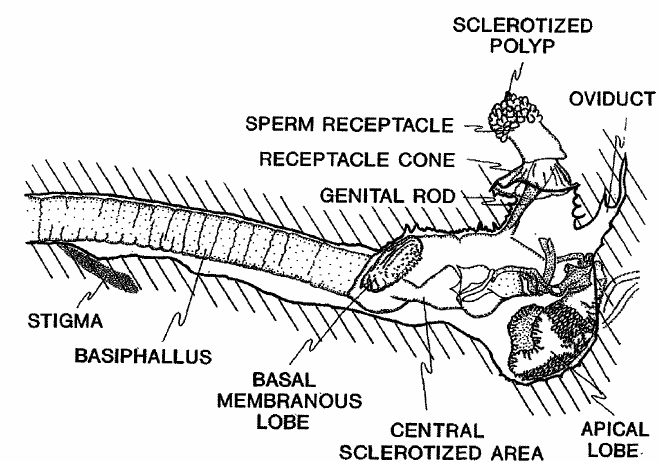
Fig. 1. Diagrammatic cutaway view of positions of male genitalic structures in the female bursa when the male genital rod is inserted in the ventral receptacle of the female (see also Fig.